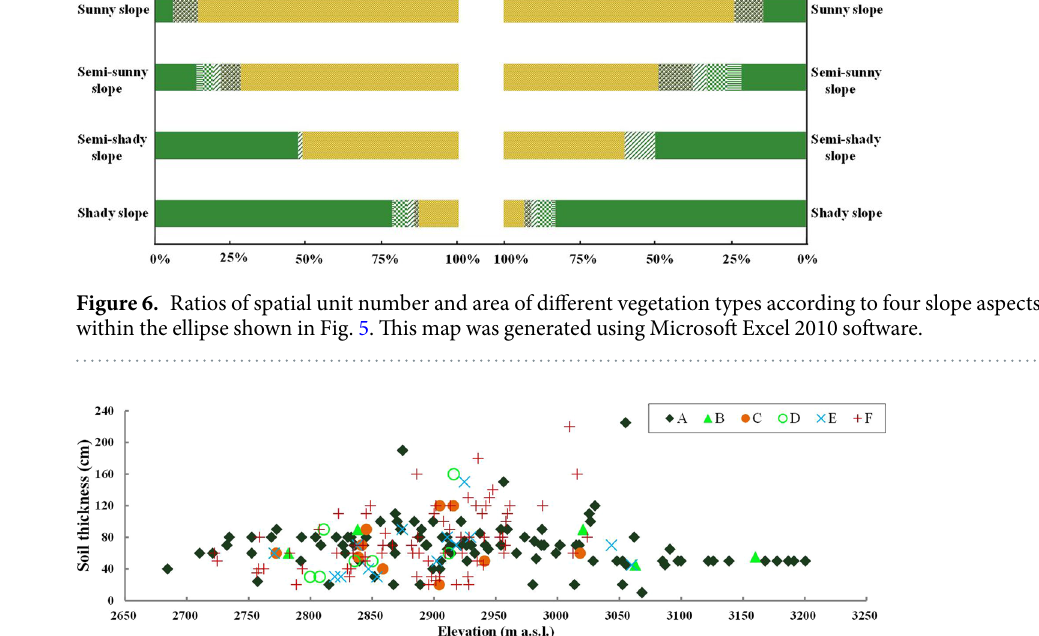
Figure 7. Soil thickness composition of all vegetated units within the potential distribution area of Qinghai spruce forests. This map was generated using Microsoft Excel 2010 software.